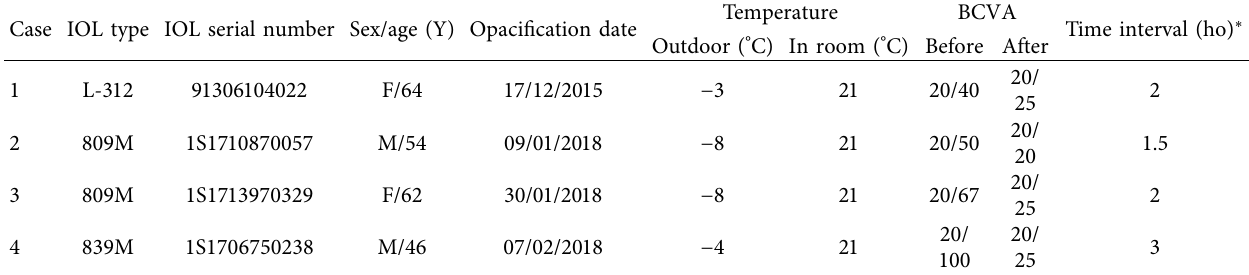
Figure 2: Clinical slit-lamp photograph of bilateral opacification of L-312 IOLs. Note the granular and diffuse opacification of the Table 2: Characteristics of the patients with transient IOL opacification.